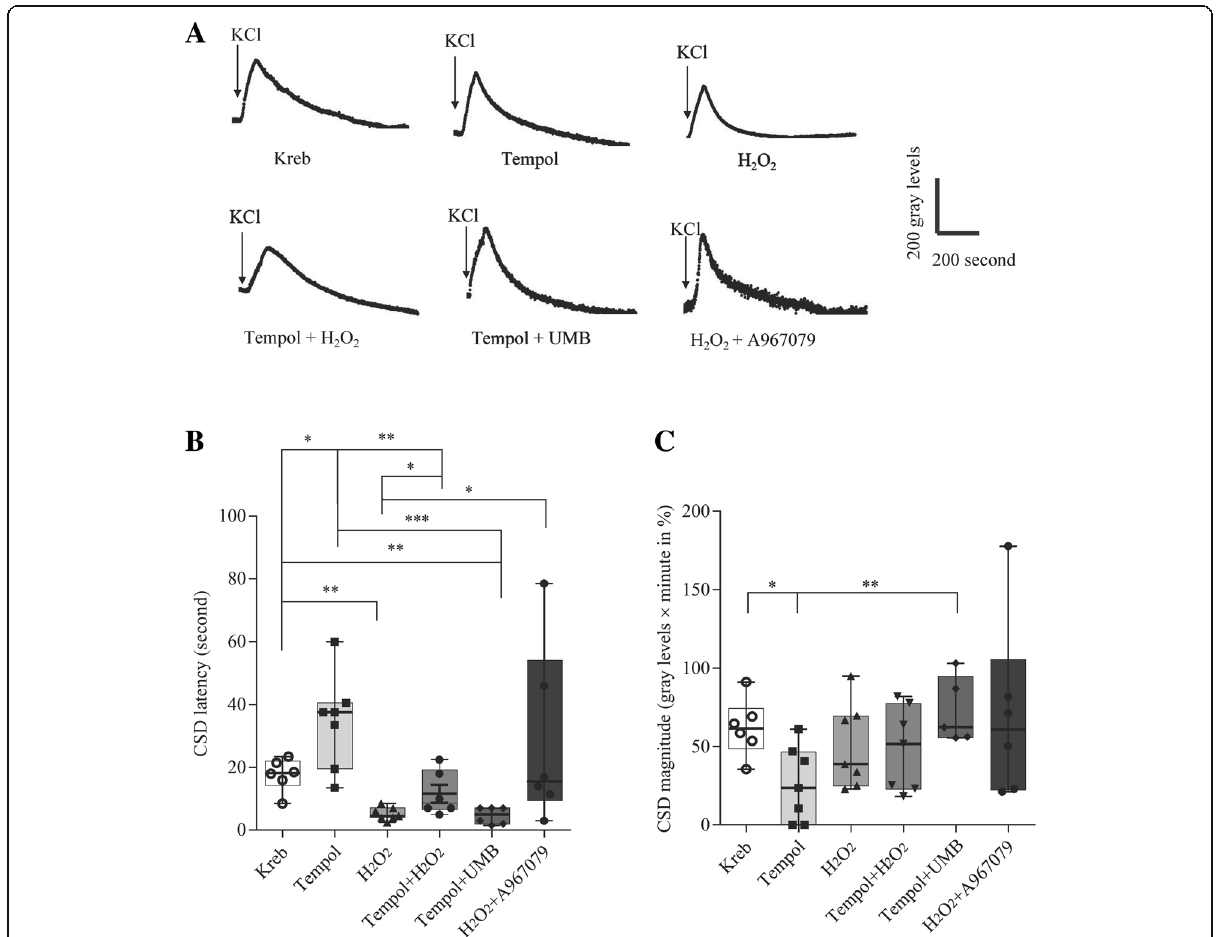
Fig. 5 Effects of modulation of ROS and TRPA1 on cortical susceptibility to CSD and their interaction during CSD in the mouse brain slice. Submaximal CSD was induced by KCl at 50mM. There were six groups: Kreb ’ s (i, n =6) as control, 3mM of the ROS inhibitor, tempol (ii, n =7), 50 μ M of ROS activator, H 2 O 2 (iii, n =6), 3mM of tempol with 50 μ M of H 2 O 2 (vi, n =8) or with 15 μ M of the TRPA1 agonist, UMB (v, n =7), 50 μ M of H 2 O 2 with 1 μ M of the TRPA1 antagonist, A967079 (vi, n =6). In order to minimize the animal use, data in Kreb ’ s control group were adopted and transformed from that in Fig. 4 in